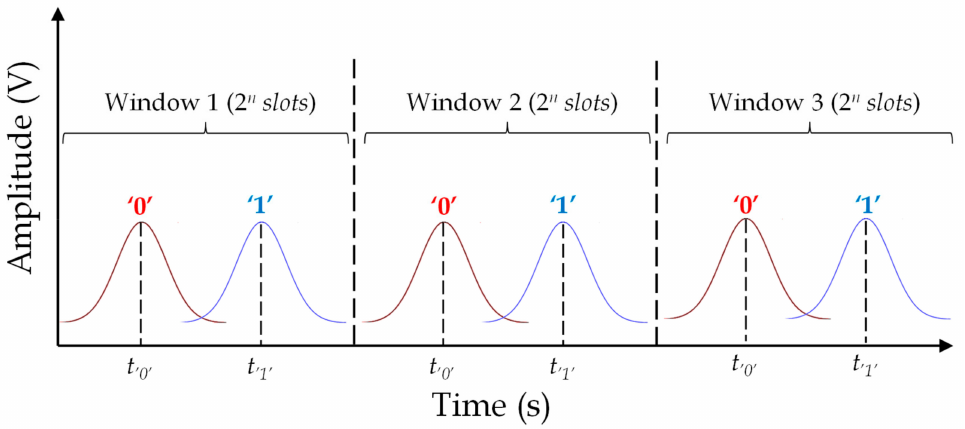
Figure 7. Working principle of pulse position modulation